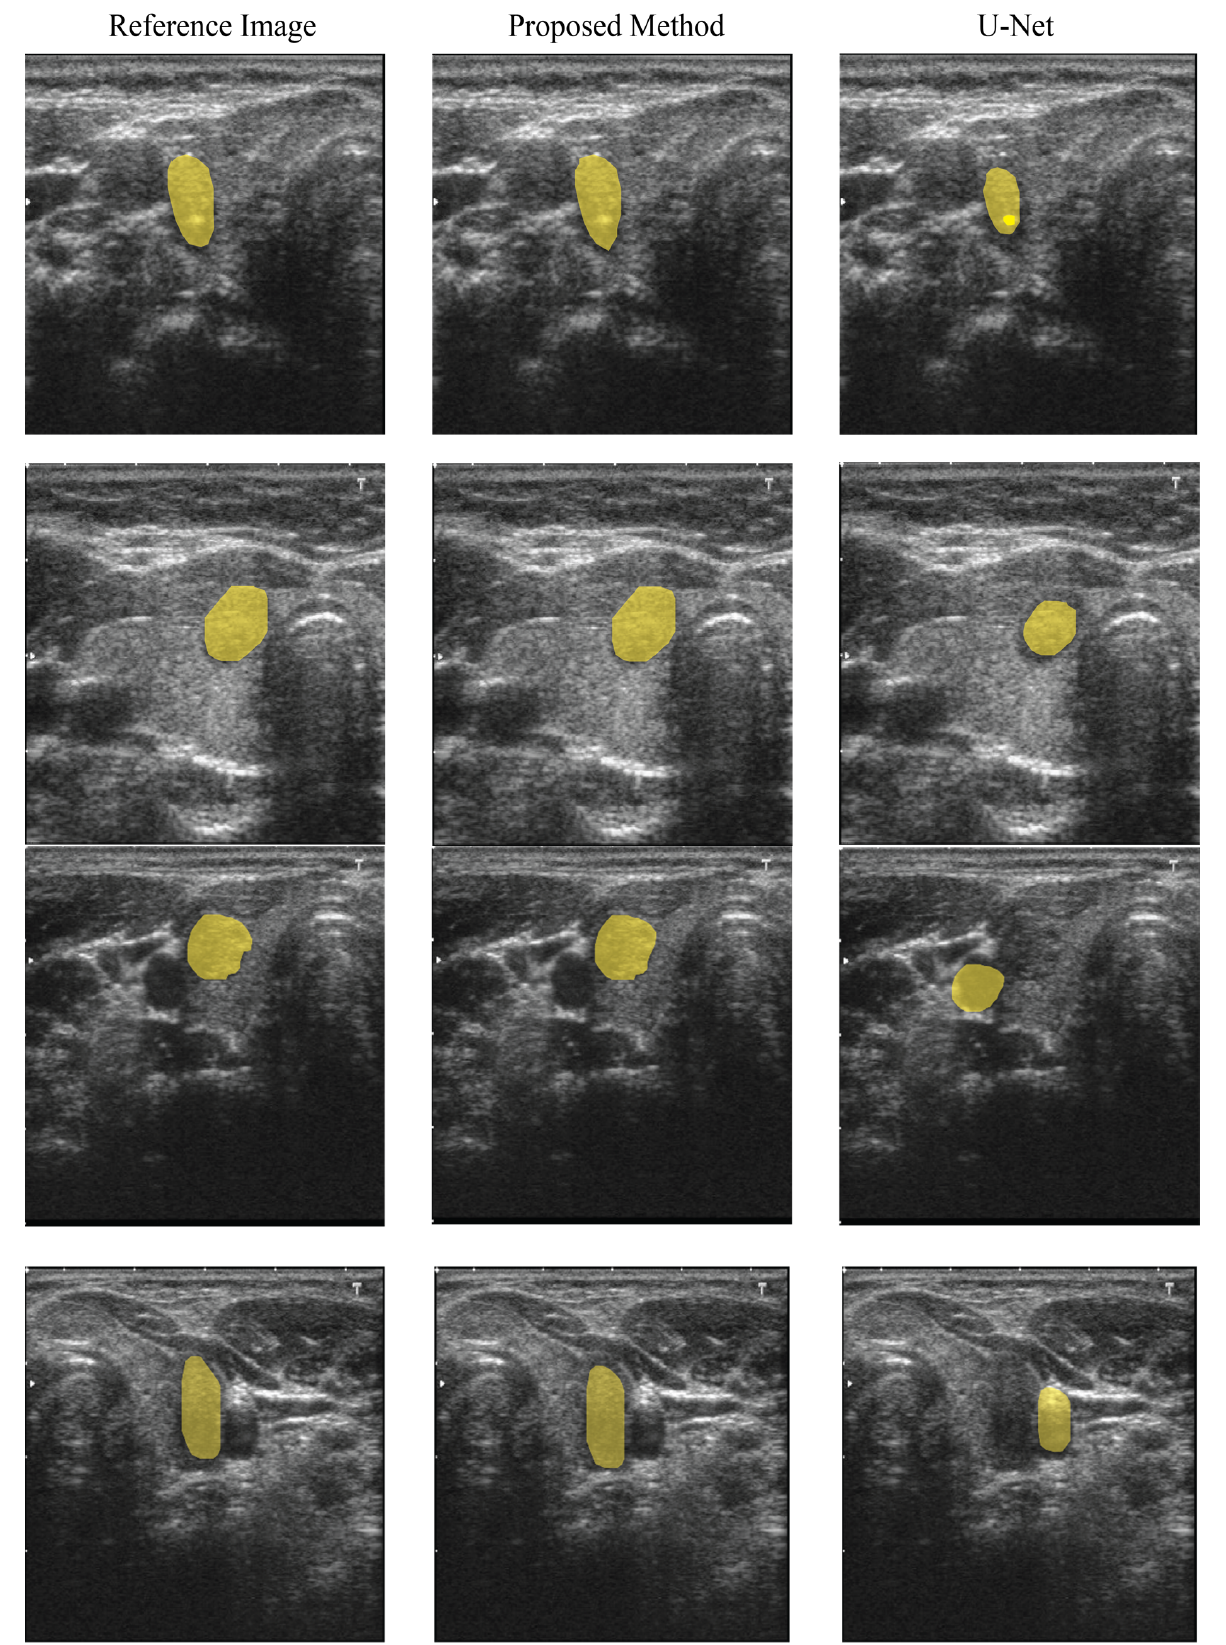
Figure 4. Segmentation output results of the proposed and benchmark methods.